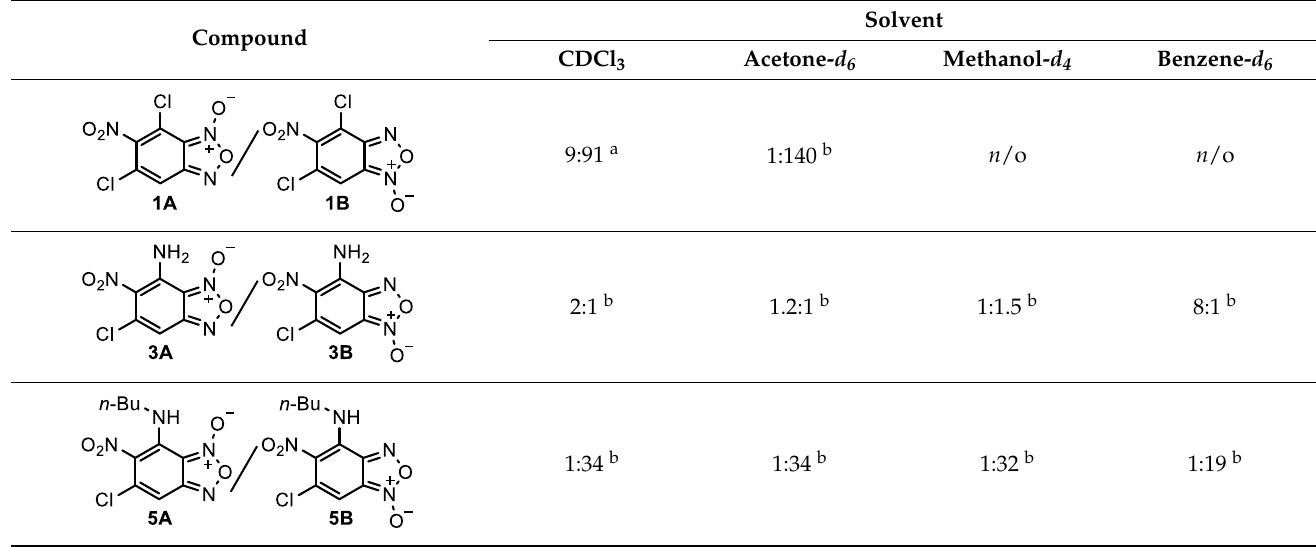
Table 1. Tautomeric ratio for the benzofuroxans 1 , 3, and 5 in various solvents. Compound